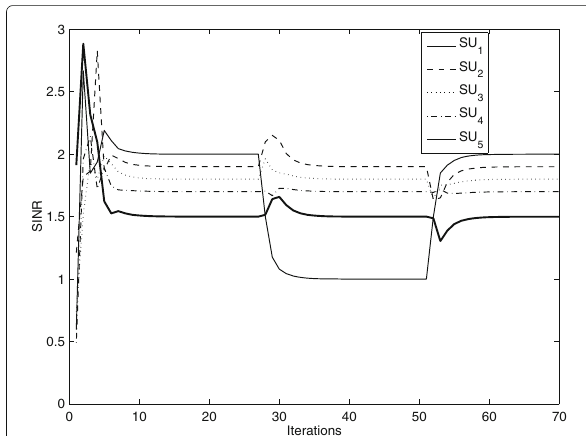
Fig. 7 The variations of SUs’ power versus the number of iterations for a variable number of SUs